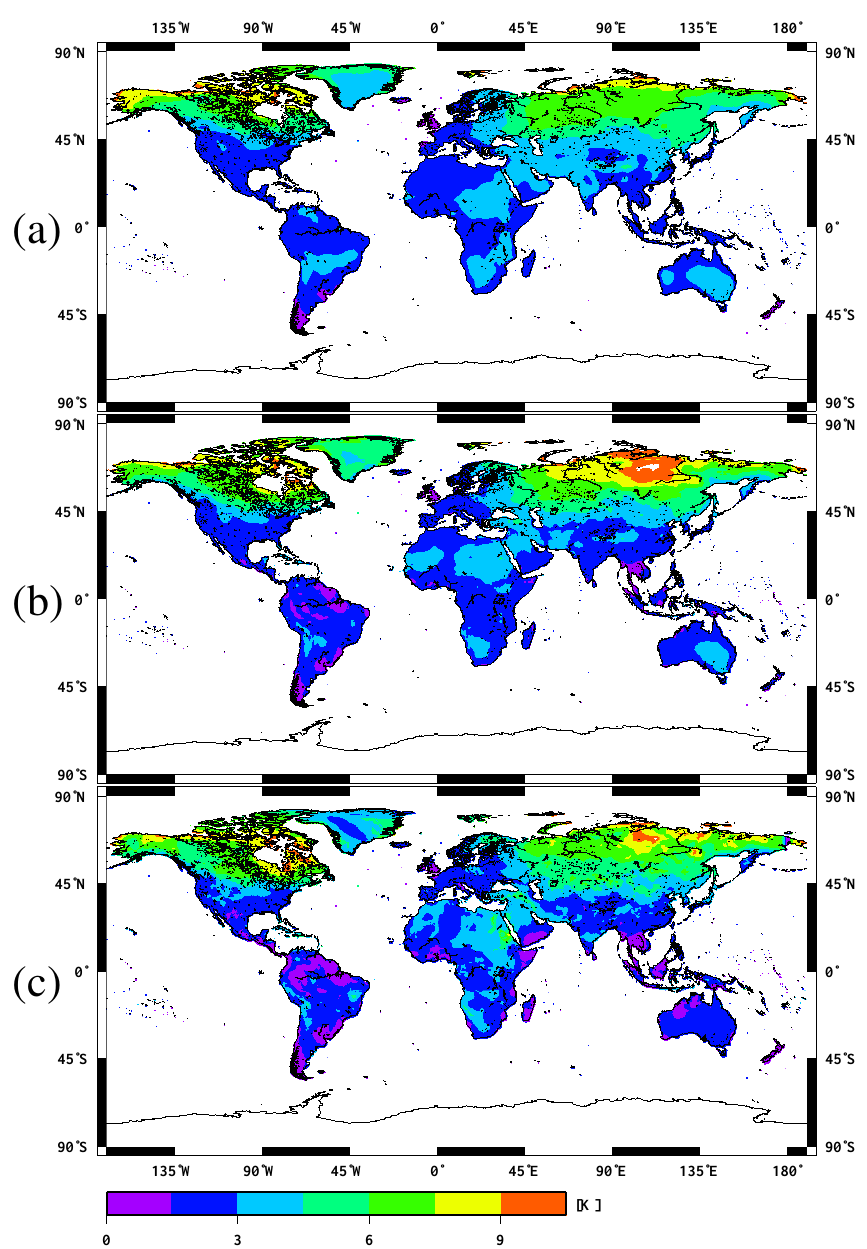
Fig. 7. Temperature climate change signal for the B1 emission scenario projected by ECHAM5 for the period 2070–2099 relative to 1960– 1999 for December; (a) , model without bias correction; (b) , standard bias correction; (c) , cascade bias correction.